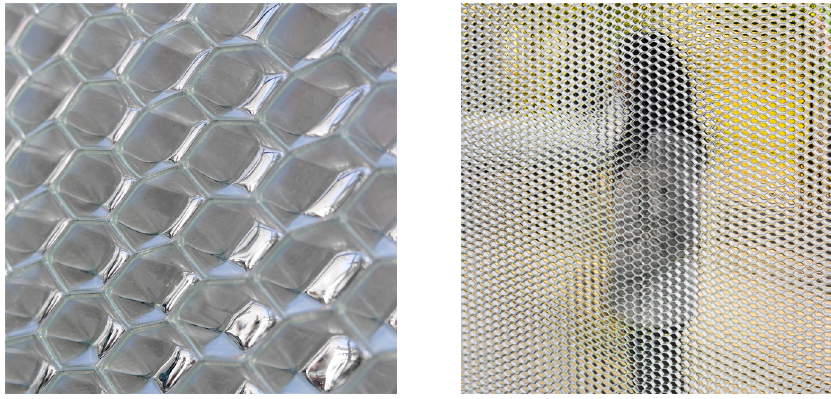
Figure 1a and b: Glass-honeycomb composite